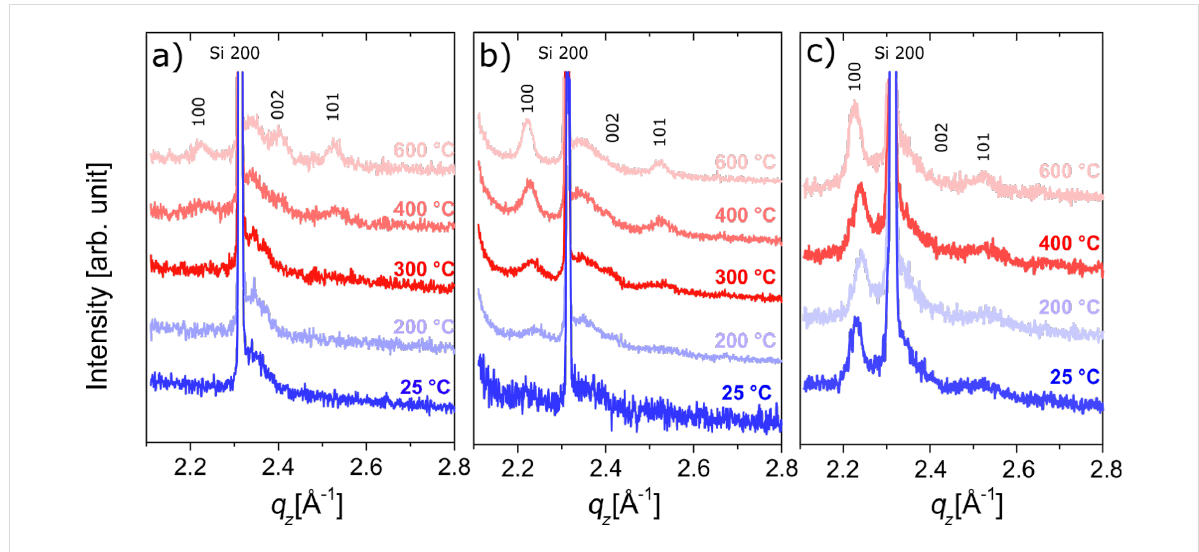
Figure 4: In situ XRD measurements performed during calcination between 25 and 600 °C for the zincone-like layers deposited with a) 1 s plasma exposure time, b) 2 s plasma exposure time, and c) 4 s plasma exposure time. Bragg peaks originating from ZnO and Si are indicated by their respec- tive Miller